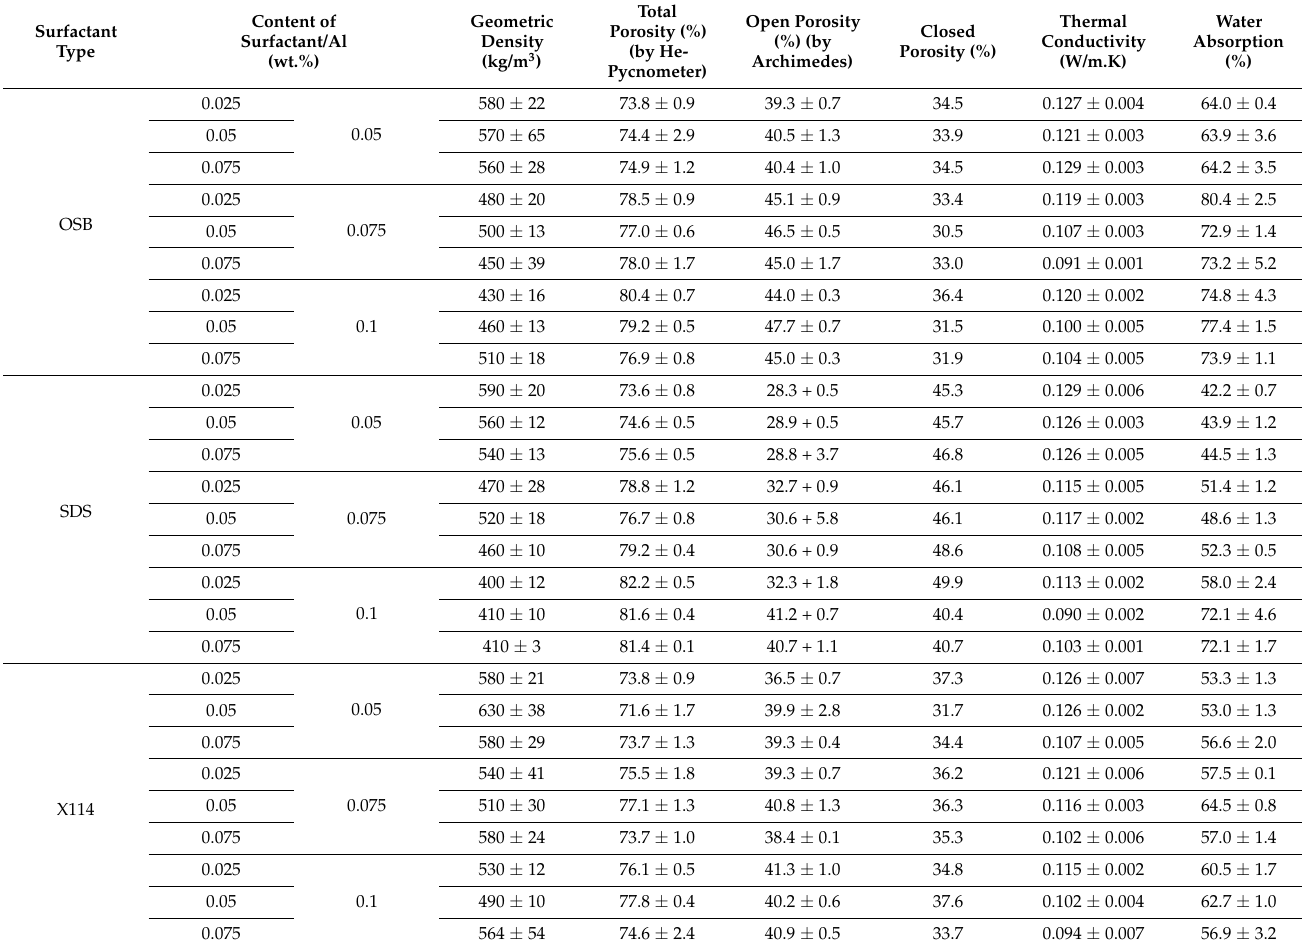
Table 3. Geometric density, porosity, thermal conductivity, and water absorption values of